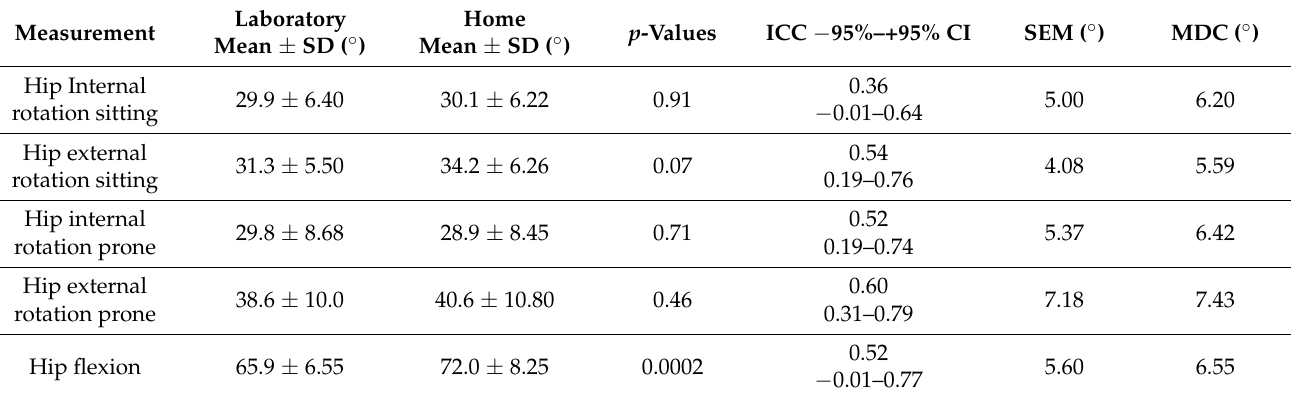
Table 4. Comparison of video analysis measurements in the laboratory and at home: means ± standard deviations, one way ANOVA p -value, ICC and 95% confidence intervals, SEM, and MDC.